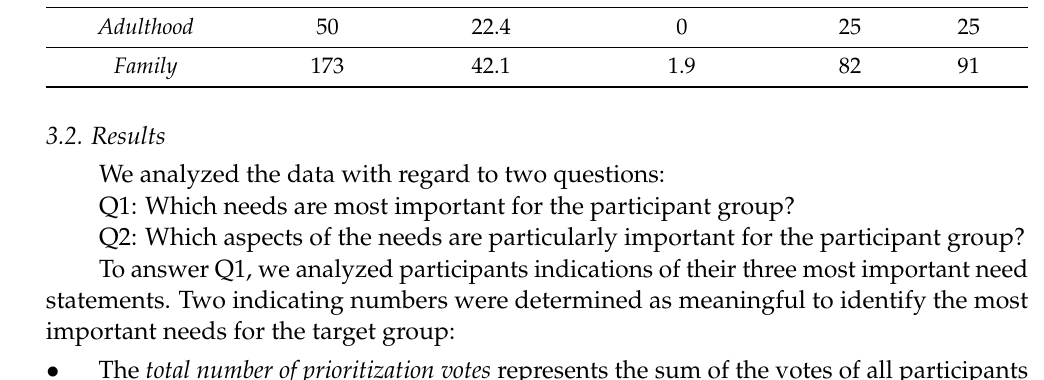
Table 3. Demographical characteristics of the participants of the two target groups. Target Group Sample